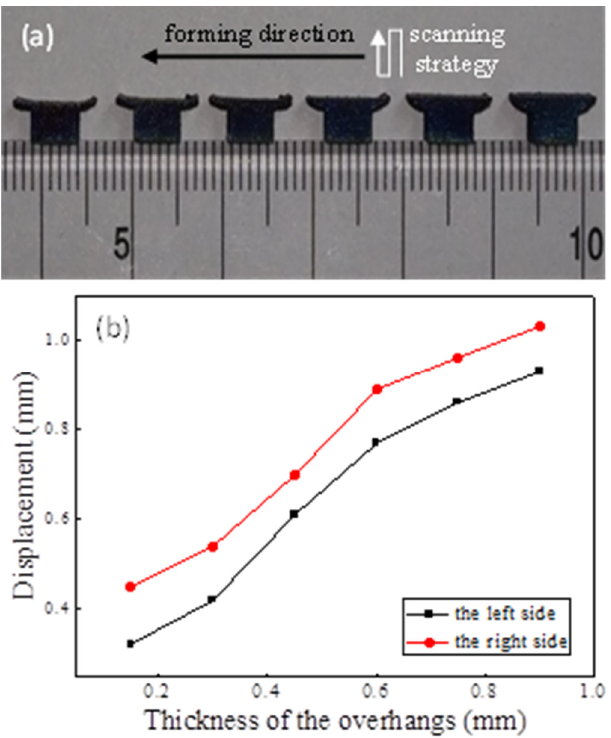
Figure 9. ( a ) The as-fabricated T-shape overhangs (length = 2 mm, width = 5 mm, thickness = 0.15, 0.3, 0.5, 0.7, and 0.9 mm, respectively). ( b ) Displacements of the edges of the overhangs in the building direction.